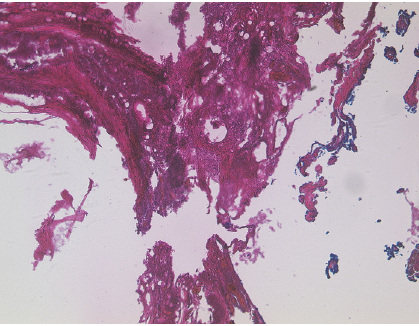
Figure 4: Dermoid cyst with stratified epithelium with associated skin appendages like keratin lamellae and sebaceous glands (haema- toxylin and eosin staining).